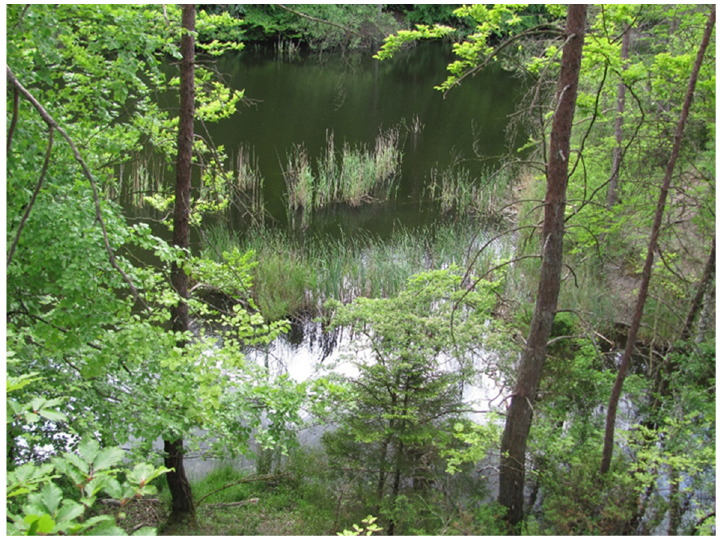
Figure 5. View from the escarpment over the Stara Kredownia reservoir (photo: Konrad Wrzecionkowski).